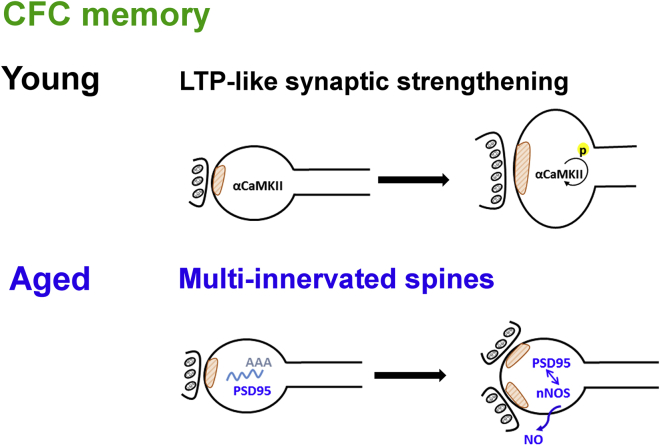
Model for Distinct Memory Mechanisms in Young and Aged MiceIn young mice, memory appears to underlie an LTP-like synaptic strengthening that involves the autophosphorylation of CaMKII and structural changes at existing synapses. In aged mice, memory appears to underlie MIS generation caused by nitric oxide retrograde signaling due to PSD-95-nNOS interaction.